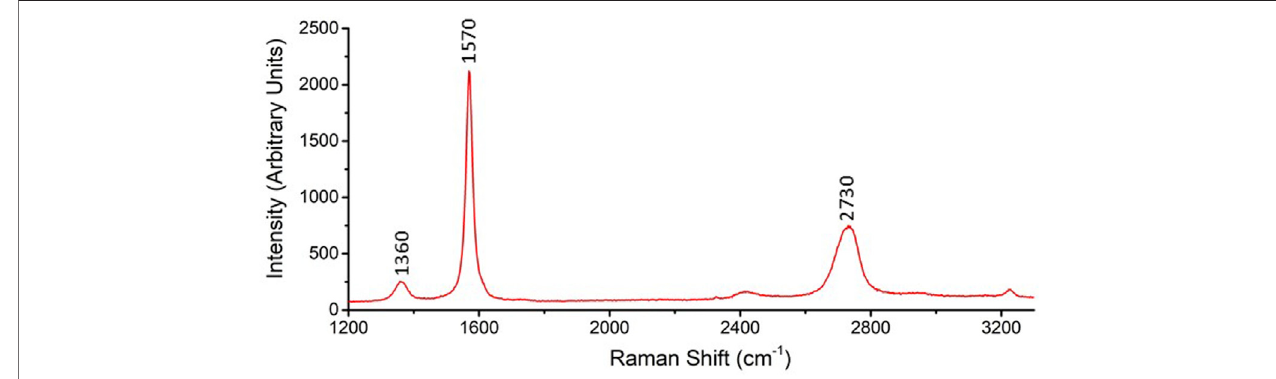
FIGURE 2 | Raman spectra for SEG fi lms used as conductive layers in TENGs.